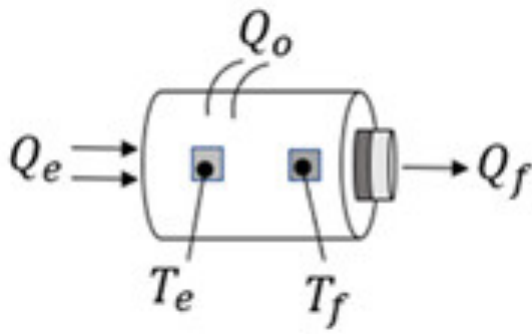
Figure 3. Schematic representation of thermocouple positioning in the experimental setup.